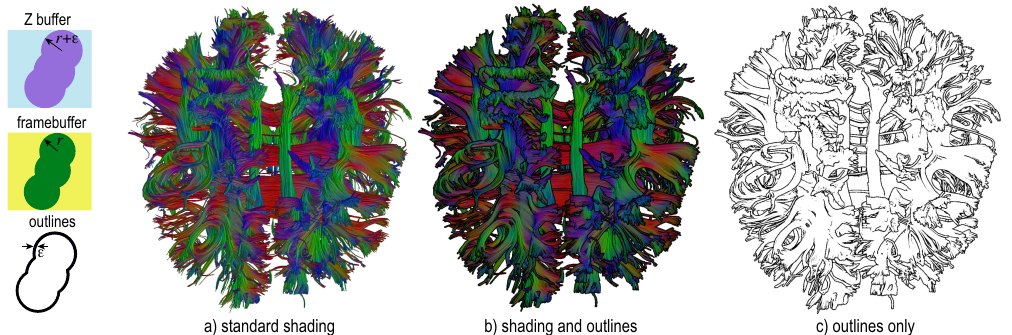
Figure 11. Creating bundle outlines. Trail set rendered ( a ) with shading but no outlines, ( b ) with shading and outlines, and ( c ) as outlines only. See Section 3.3.4.